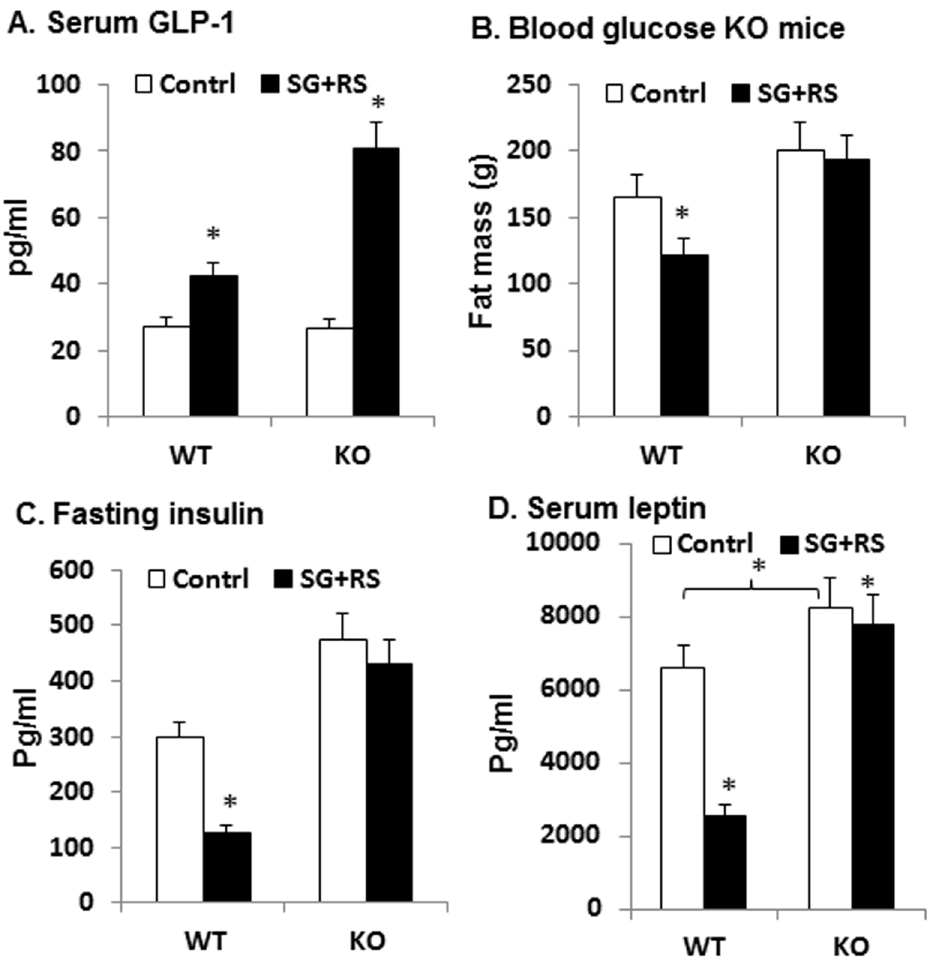
Fig 4. Serum GLP-1. A. Serum GLP-1 in mice. C. Fasting blood glucose. D. Fasting insulin. E. Serum leptin. The results are expressed as mean ± SEM (n = 12). * p < 0.05 treated vs.